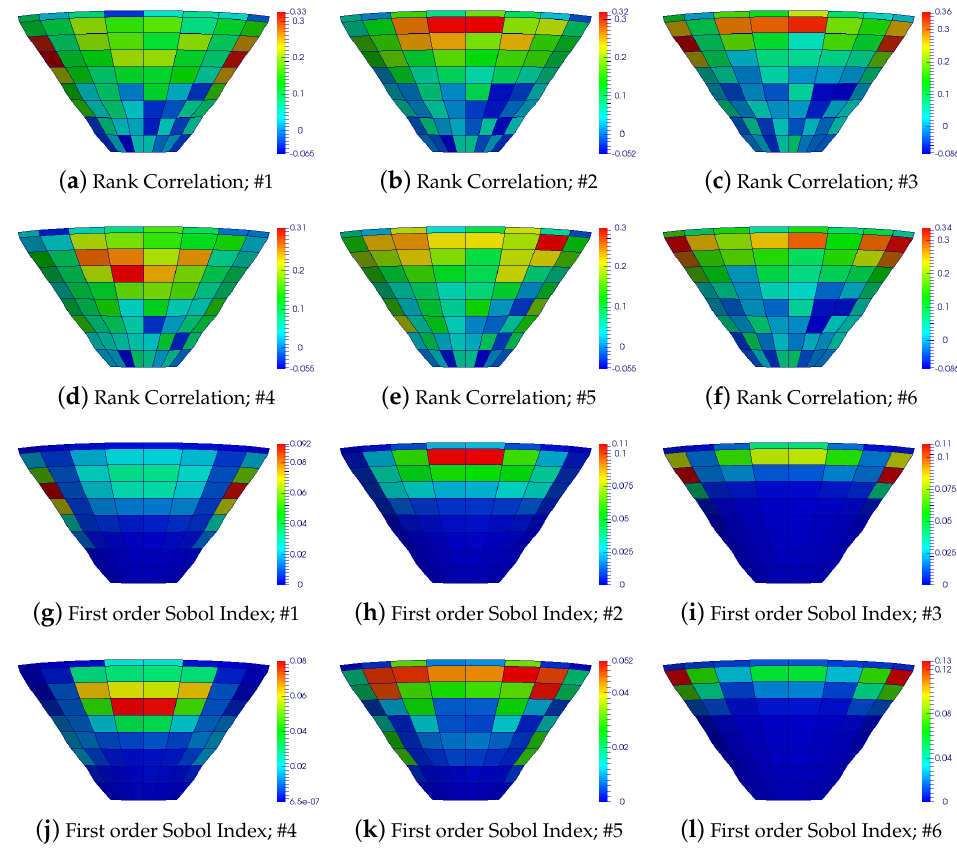
Figure 8. Dam-1; Spatial distribution of sensitive location for different vibration